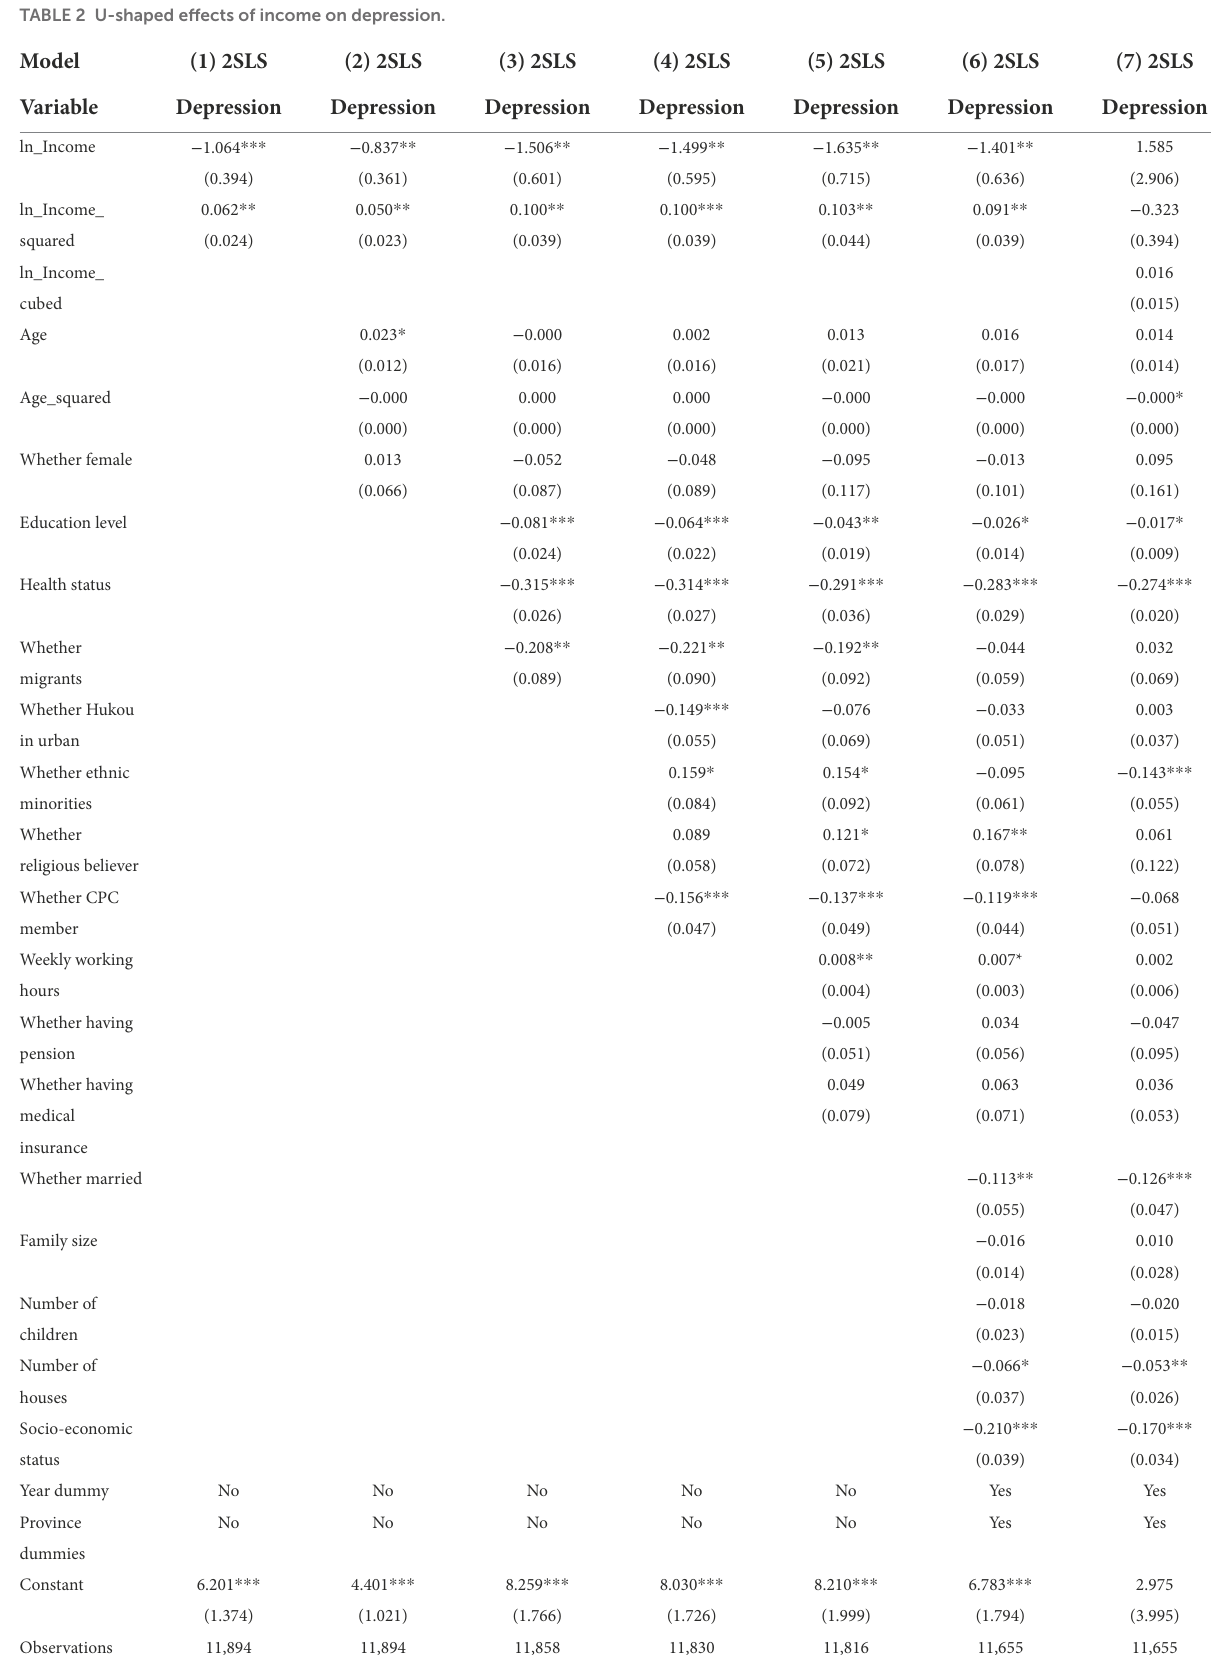
TABLE 2 U-shaped effects of income on